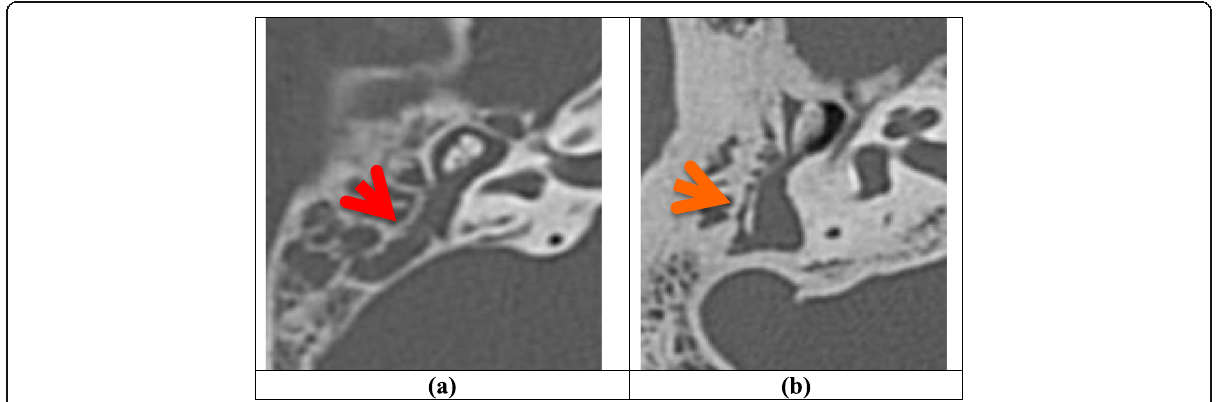
Fig. 3 Köerner ’ s septum (colored arrowheads) is shown as a thin bony plate at the lateral most portion of the mastoid cavity, seen slightly interrupted ( a ) and complete in ( b )